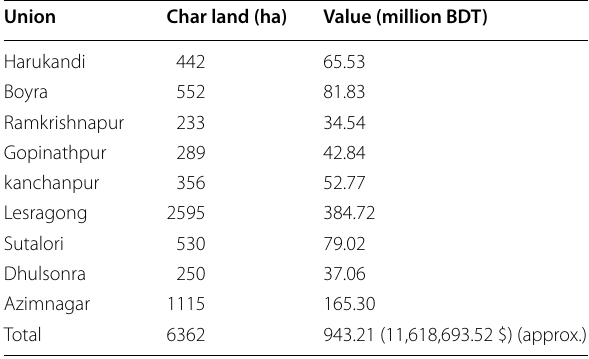
Table 4 Price of the existing char lands in study